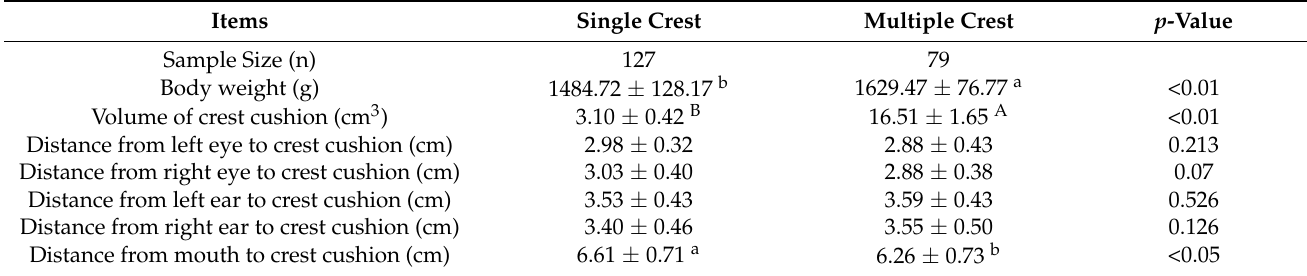
Table 3. Effect of the number of crested cushions on the weight of ducks and of crested cushion